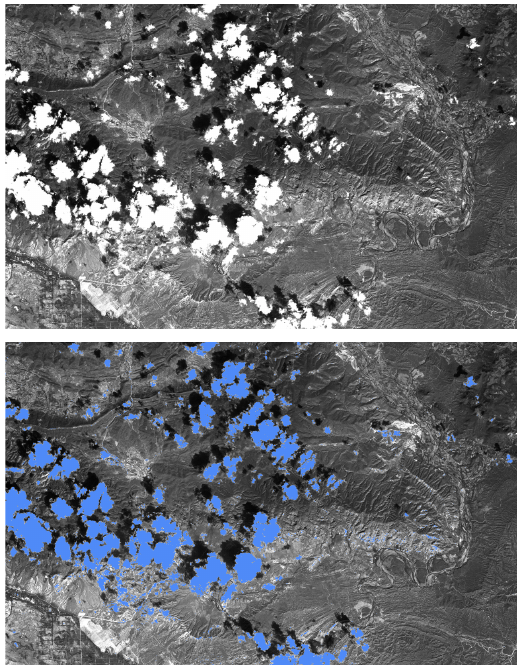
Figure 6. Zoom on the area highlighted in red in Figure 5. (top) Initial images. (bottom) Clouds detected by the method are highlighted in